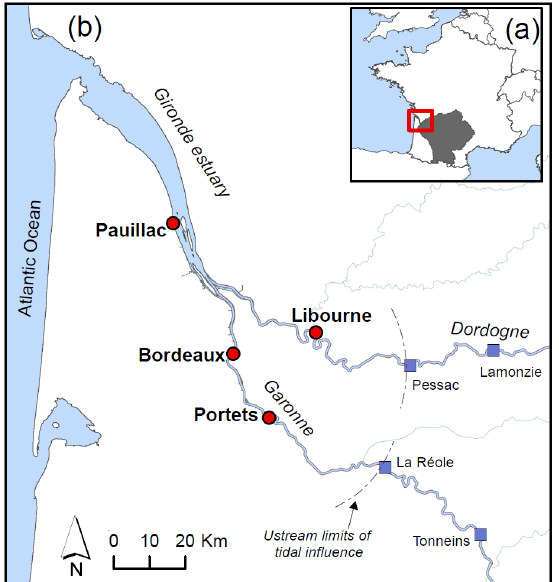
Figure 1. The Gironde fluvial-estuarine system: (a) location map (SW France), the grey area shows the watershed of Garonne and Dordogne; (b) the estuary with its main tributaries. Red circles lo- cate the MAGEST stations; blue squares indicate the hydrometric